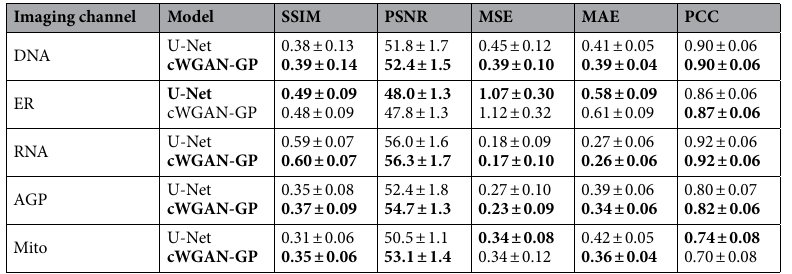
Table 2. Image metrics for each channel for the two models. The best performing model for each channel metric is highlighted in